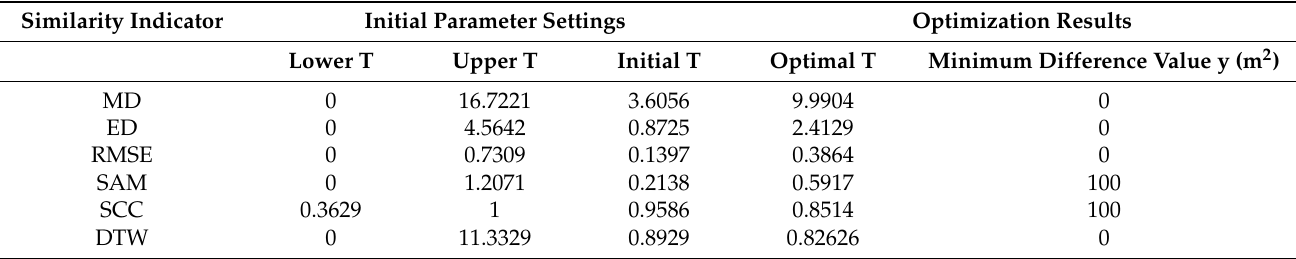
Table 2. Optimization of threshold parameters of the winter wheat extraction model. Similarity Indicator Initial Parameter Settings Optimization Results Lower T Upper T Initial T Optimal T Minimum Difference Value y (m 2